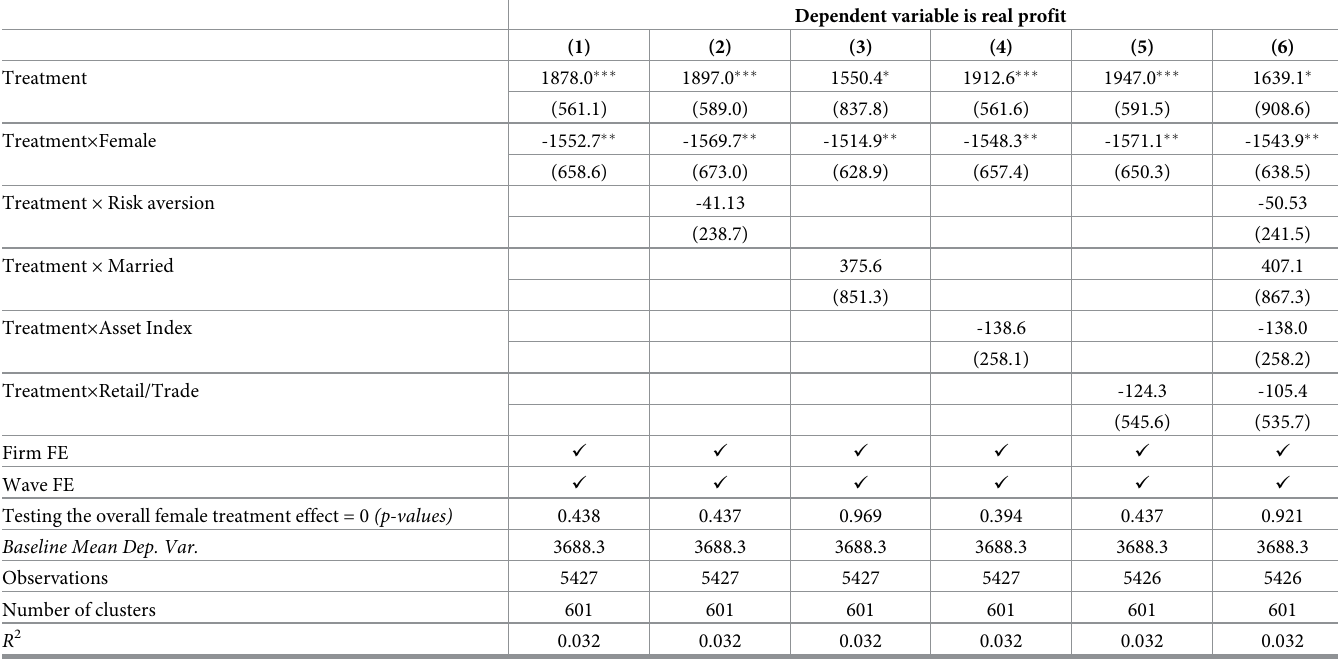
Table 5. Difference in treatment effects after controlling for other observable